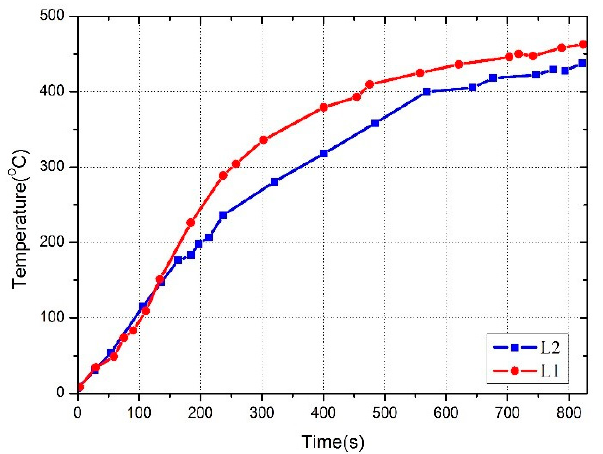
Figure 17. Variation in turbine housing warm-up temperature with time, based on data of the thermal camera.